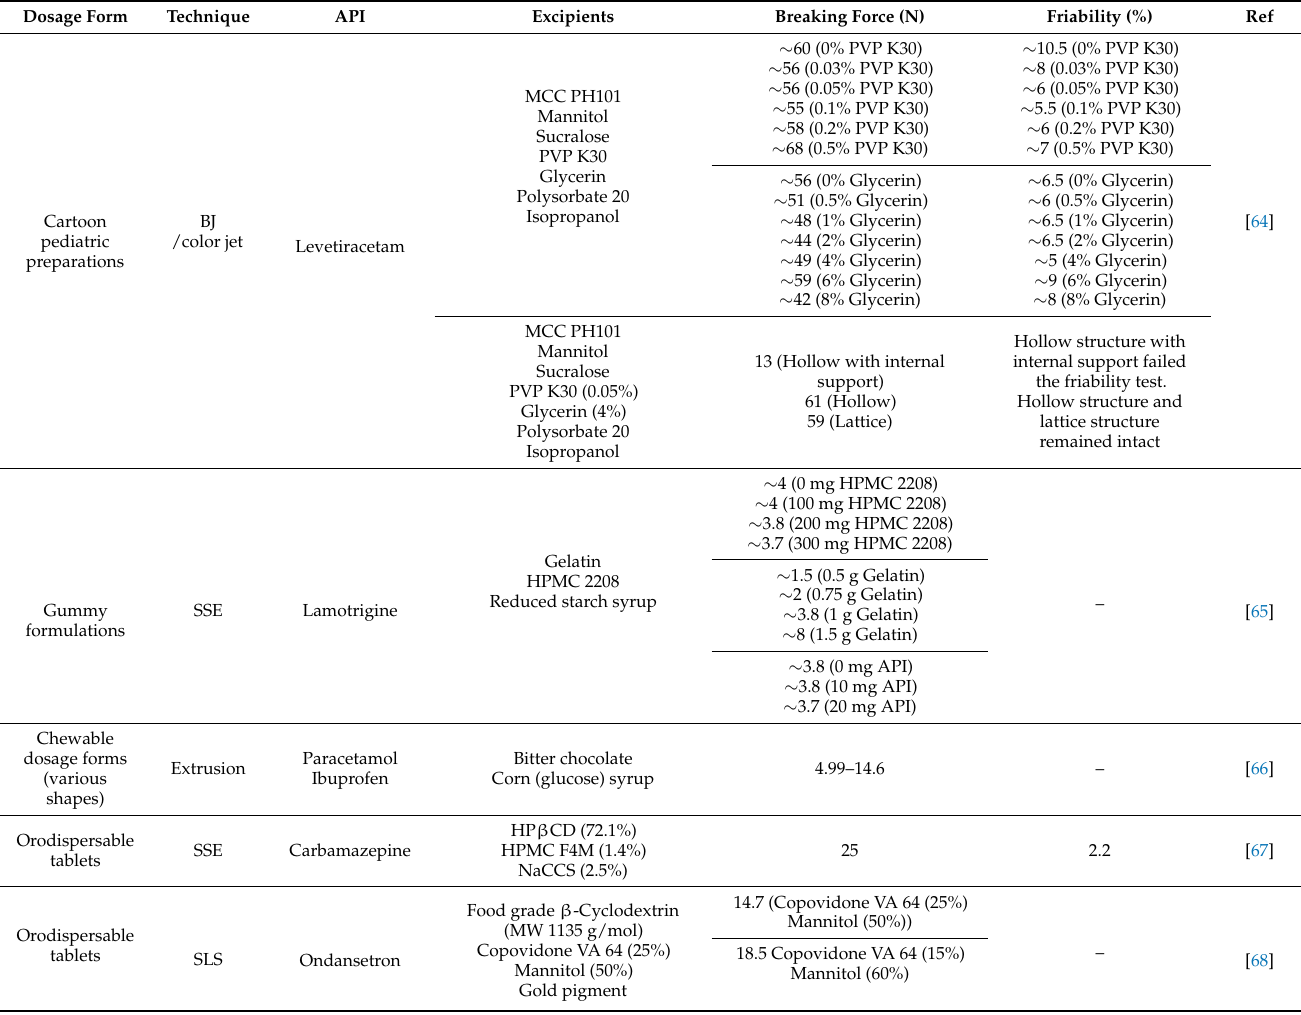
Table 1. Composition of 3D-printed solid immediate release oral dosage forms linked with breaking force (N) and friability (%). Dosage